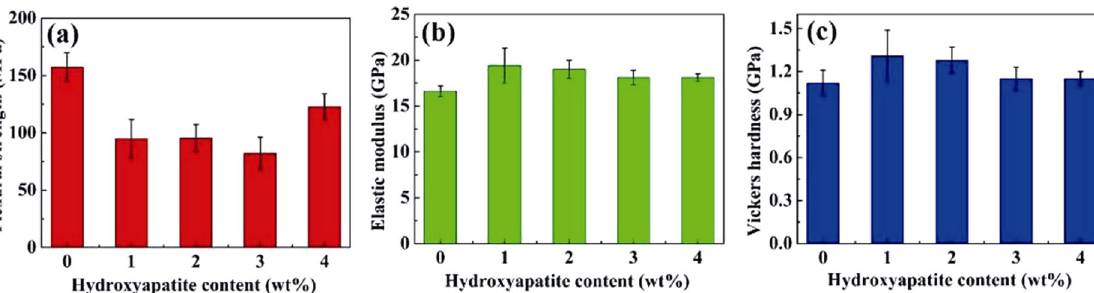
Fig. 2 SEM observations of PICNs: (a) PICN without hydroxyapatitea and (b) PICN with 2 wt% hydroxyapatite.